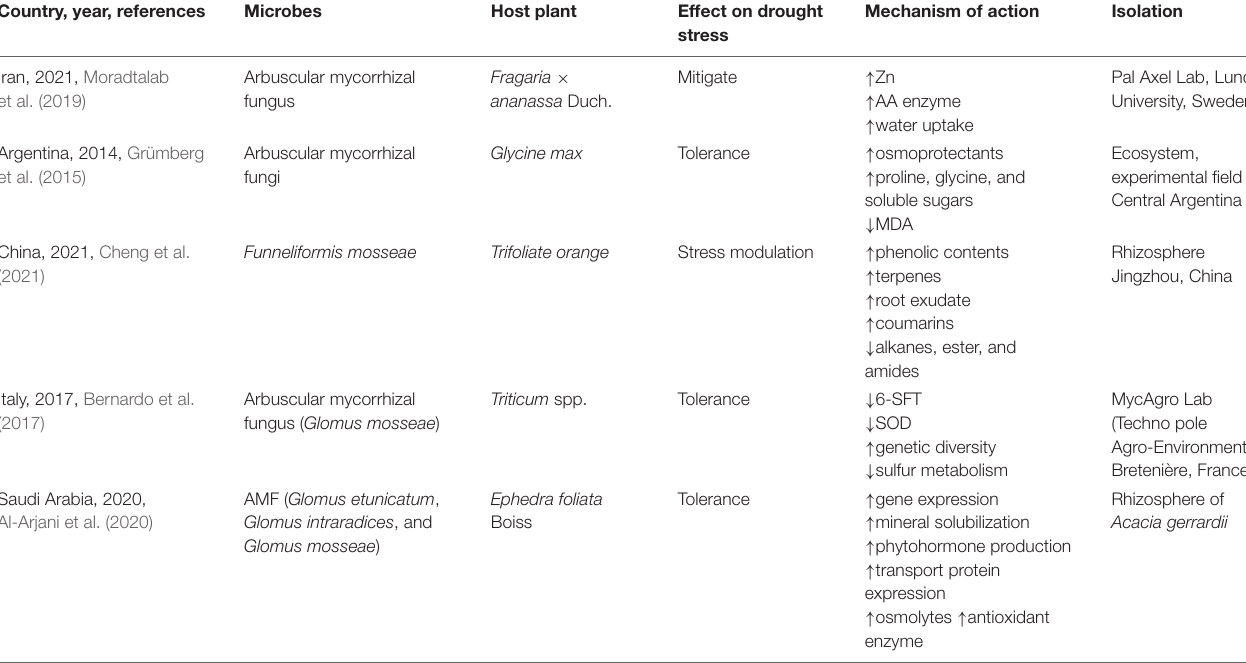
TABLE 6 | Mycorrhizae mitigate drought